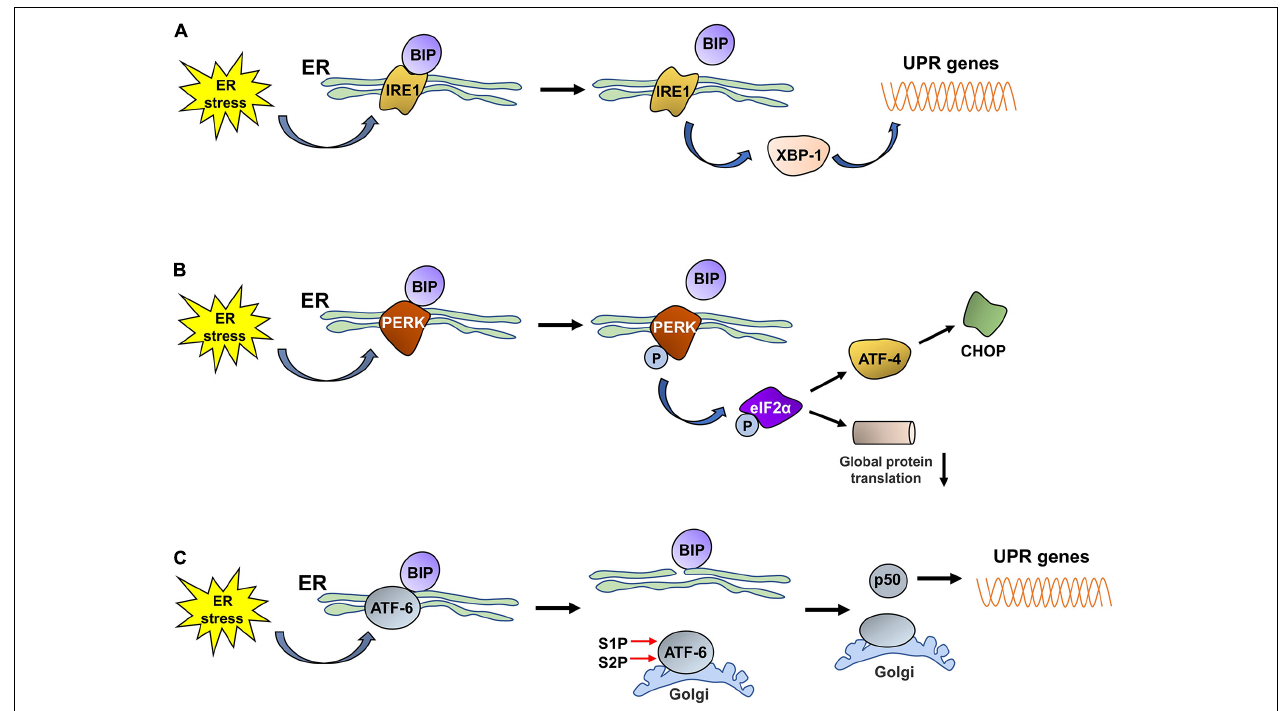
FIGURE 1 | The three UPR pathways activated by ER stress. (A) Under ER stress conditions, IRE1 dissociates from BiP and is subsequently activated. Then, activated IRE1 promotes the translation of XBP1, and increased XBP1 levels promote the expression of UPR proteins. (B) Under ER stress conditions, PERK dissociates from BiP and is then self-phosphorylated; phosphorylated PERK induces the phosphorylation of eIF2 α . Phosphorylated eIF2 α decreases the rate of global protein translation and upregulates the expression of ATF4, which promotes CHOP expression. (C) ER stress promotes the dissociation of ATF6 from BiP. ATF6 is then translocated to the Golgi, where it is cleaved by S1P/S2P, and the cytosolic p50 fragment is released. p50 upregulates the expression of XBP1; subsequently, the expression of UPR-related proteins is also